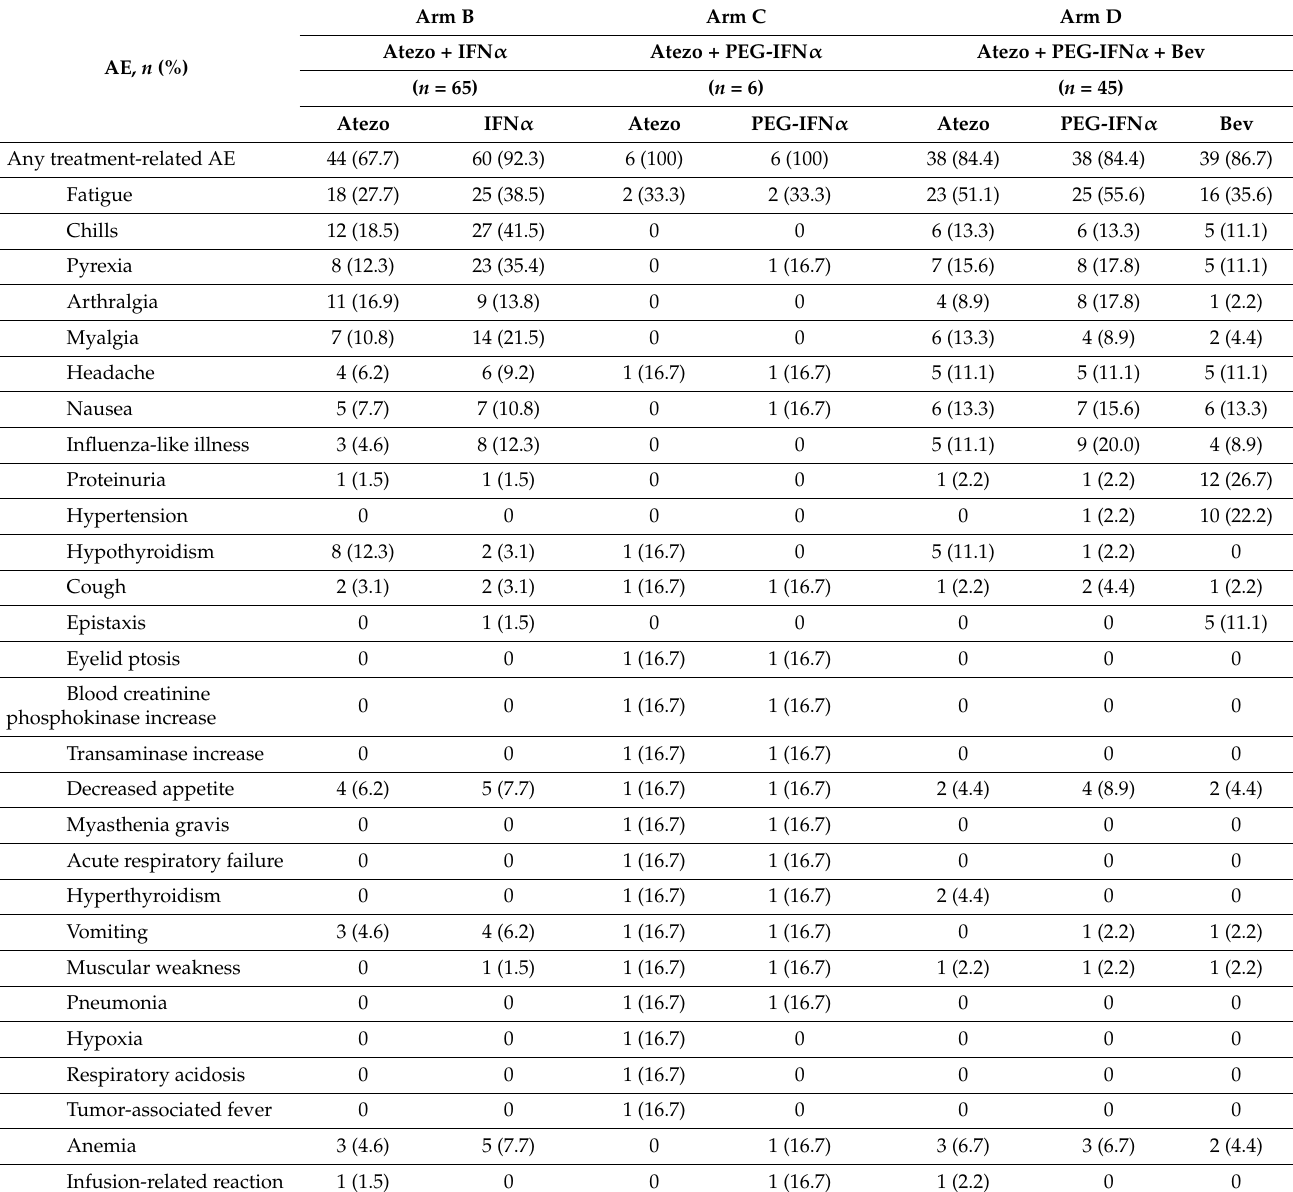
Table 3. Most common treatment-related AEs of any grade (reported in ≥ 10% of patients in any